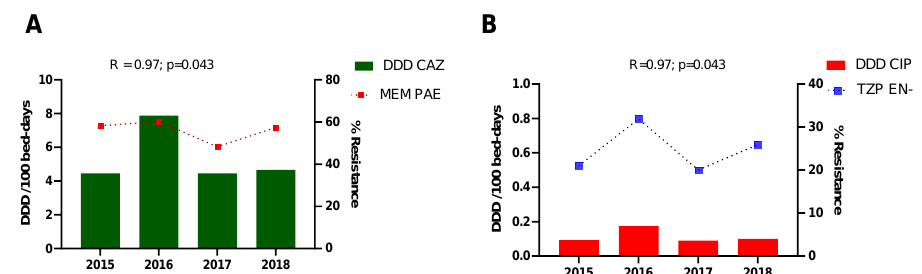
Figure 4. Antimicrobial consumption and correlation with resistance for specific pathogen in medical wards. ( A ). Ceftazidime consumption and resistance to meropenem in Pseudomonas aeruginosa . ( B ). Ciprofloxacin consumption and resistance to piperacillin / tazobactam in Enterobacter spp. DDD = defined daily doses. CAZ = ceftazidime, CIP = ciprofloxacin, MEM = meropenem, TZP = piperacil- lin/tazobactam. Table 1 . Results of the Spearman correlation demonstrating the relationship between the frequency of strains resistant to a particular antimicrobial and the consumption of antimicrobials that potentially exert selection pressure divided by ser- vices .